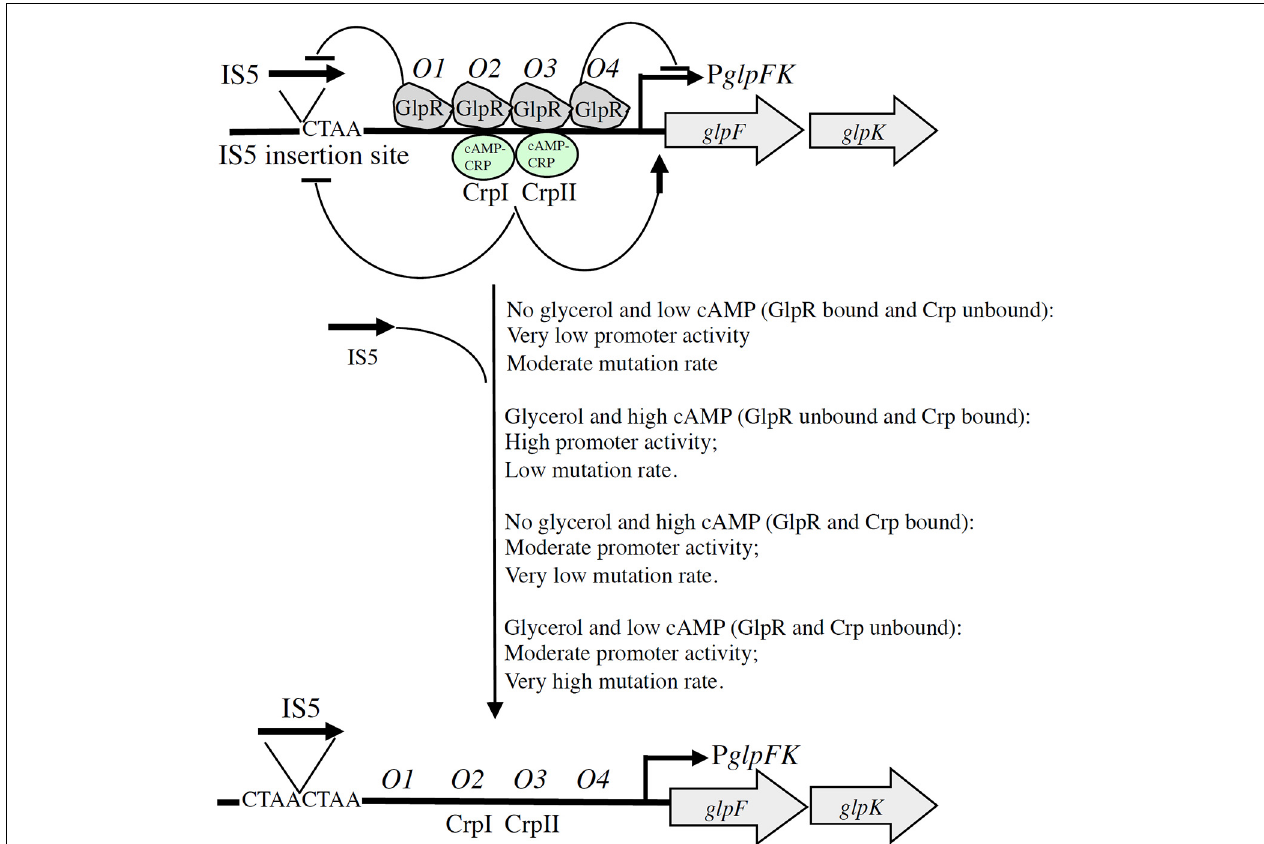
FIGURE 2 | Schematic diagram illustrating dual GlpR-mediated/cAMP- CRP-mediated control of (right) the level of glpFK transcription and (left) the rate of IS5 hopping into the activating site upstream of the glpFK promoter (directed mutation). With GlpR bound to its operators ( O1–O4 ) (in the presence of GlpR and the absence of glycerol), transcription and IS5 hoppingbothoccuratlowrates.WhenGlpRisnotboundtoitsoperators(inthe absence of GlpR or in the presence of glycerol), both transcriptional initiation